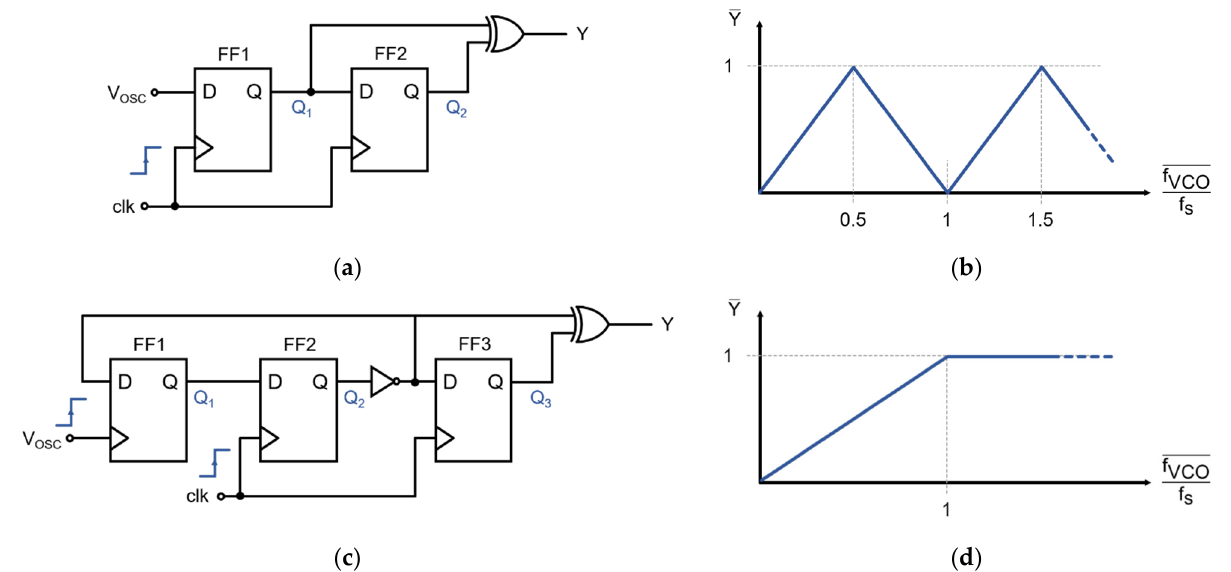
Figure 6. Frequency-to-digital (F2D) converters. ( a ) Classical 2-flip-flop exclusive OR (XOR)-based frequency-to-digital converter; ( b ) Normalized frequency-to-digital response of the classical XOR-based F2D, which is not monotonic and may feature metastable states in the closed-loop converter; ( c ) Proposed frequency-to-digital converter, with a third flip-flop to force the saturation of the F2D; ( d ) Normalized frequency-to-digital response of the proposed F2D, which is monotonic and prevents metastable operating points.